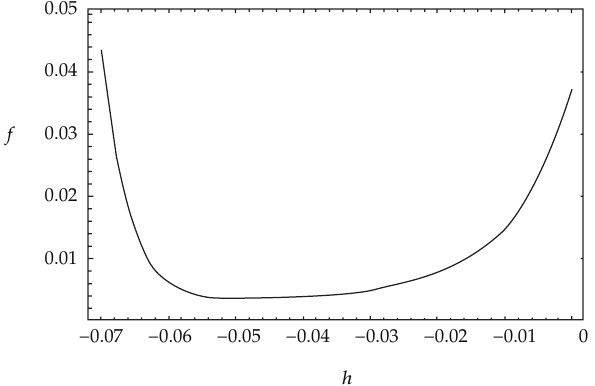
Figure 3: Residual error curve for constant